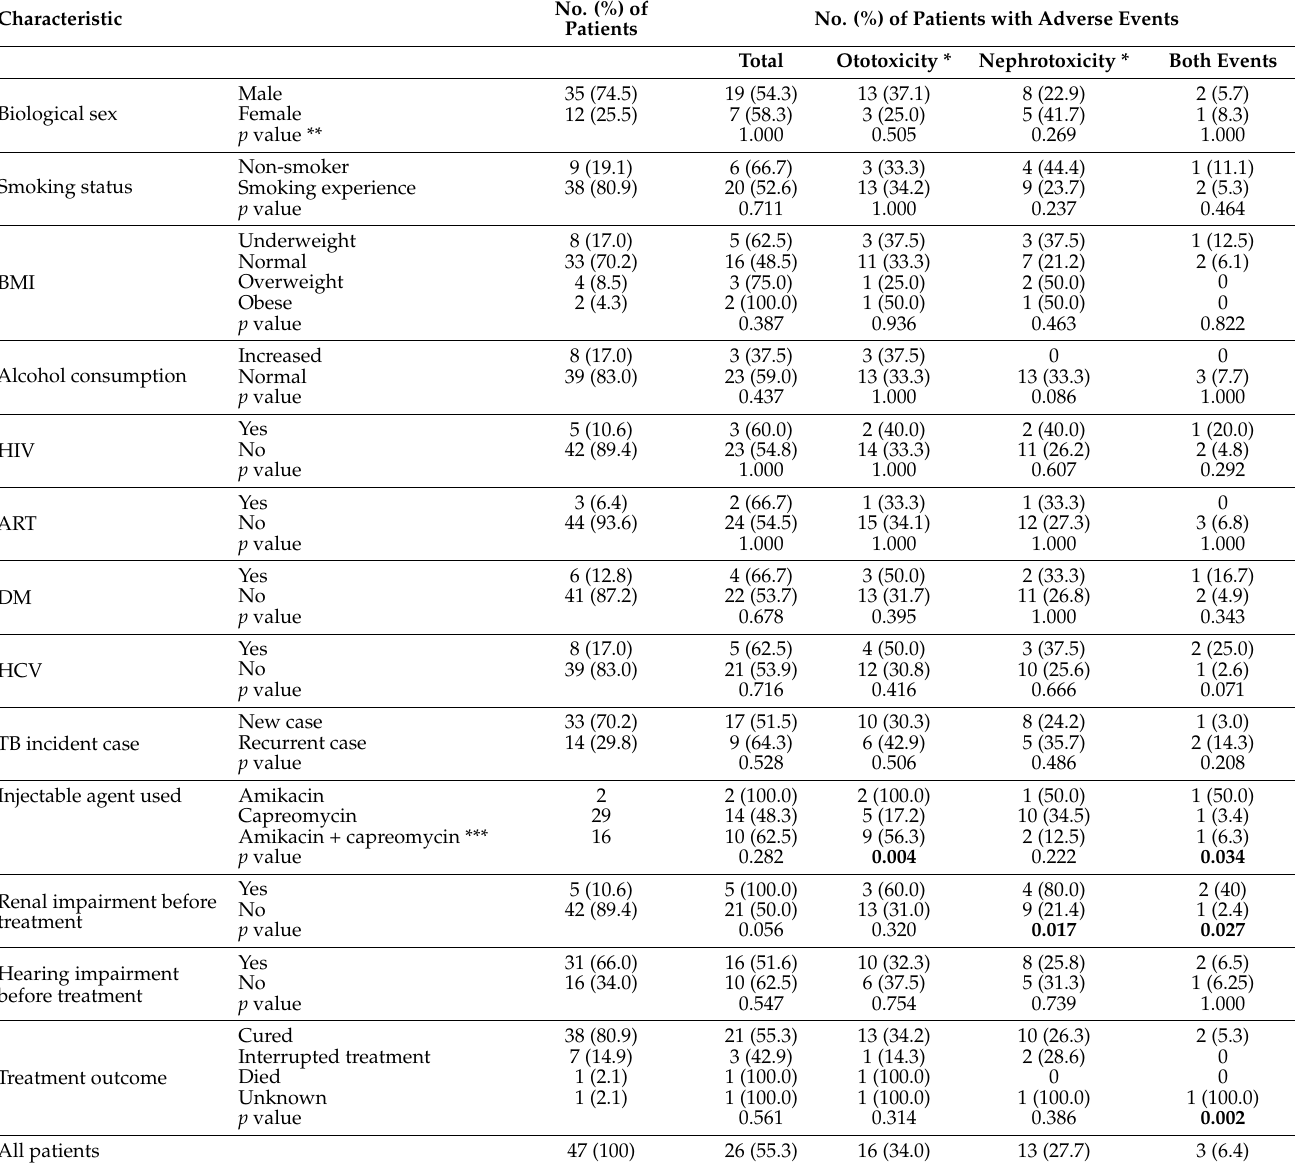
Table 1. The occurrence of ototoxicity and nephrotoxicity in patients with MDR-TB depending on various